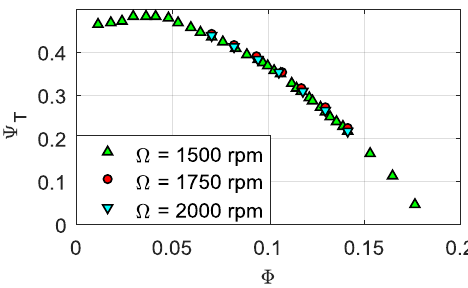
Figure 6. VAMPUFF total head ( Ψ 𝑇 ) versus flow coefficient ( Φ ) at different rotating speed ( Ω ), T ≅ 20 °C.